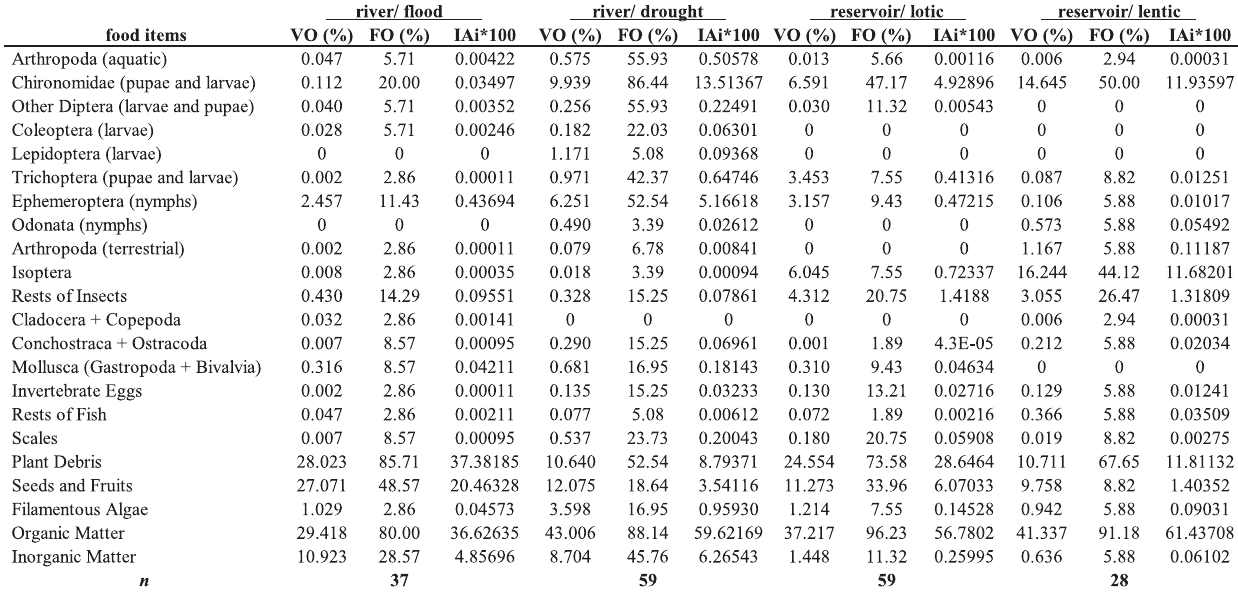
Table 1. Relative volume (VO%), frequency of occurrence (FO%) and Alimentary Index (IAi) of food items in the diet of L. taeniofasciatus from the upper rio Tocantins before and during the filling stage of the reservoir of the Serra da Mesa Hydroelectric Dam, central Brazil. Reservoir/ lotic comprises both flood and drought seasons during the filling stage, whereas reservoir/ lentic was only sampled during the flood season (up to 6 months after the closure of